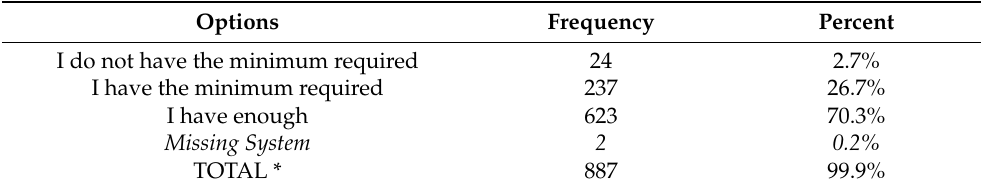
Table 3. In terms of time management, do you feel you have the necessary conditions to carry out your distance learning activity? Options Frequency Percent